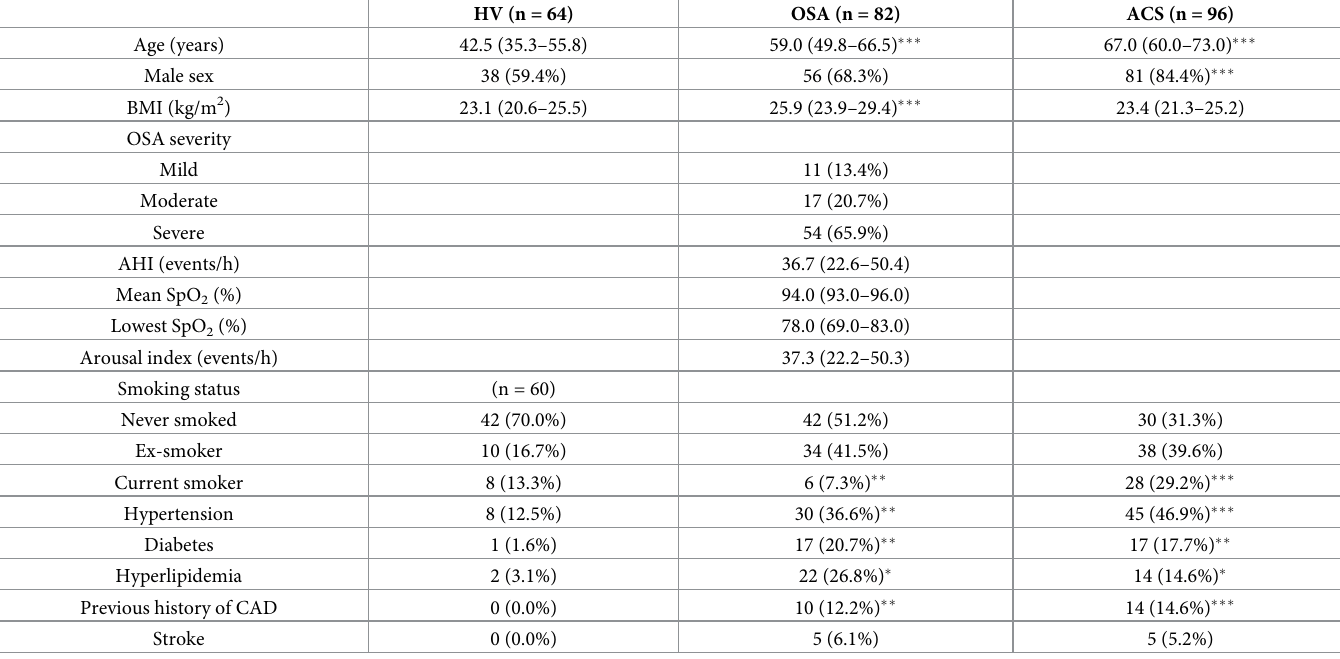
Table 1. Baseline characteristics of